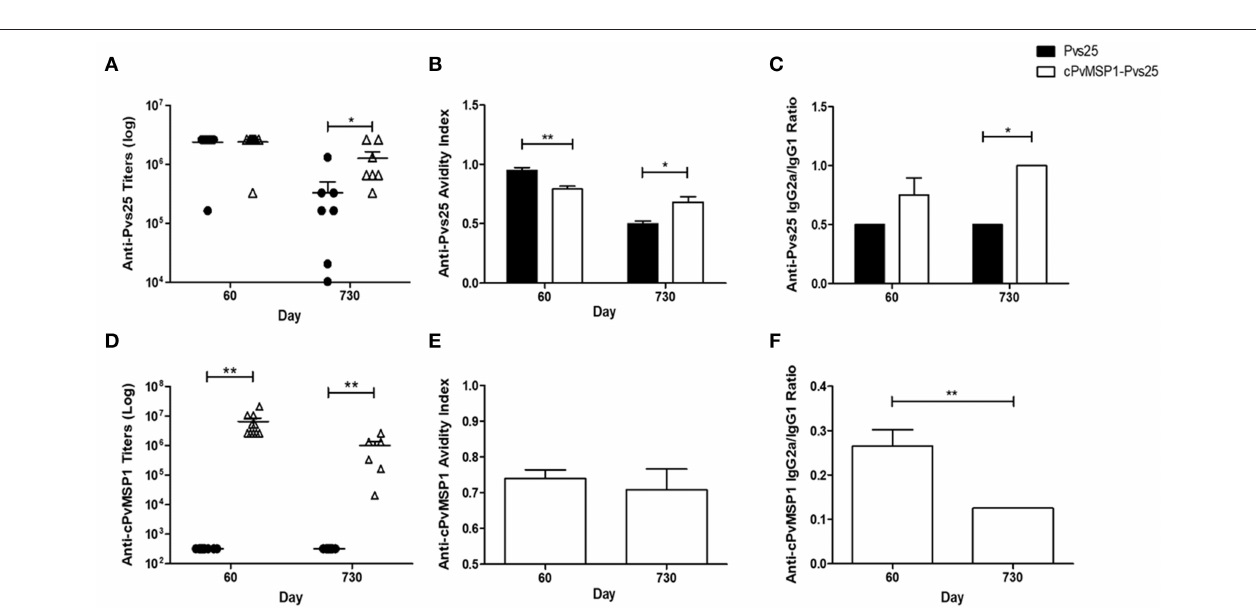
FIGURE 3 | Antibody responses to cPvMSP1 and Pvs25. Antibody responses against the recombinant cPvMSP1 and Pvs25 proteins that form the recombinant cPvMSP1-Pvs25 protein were assessed in CB6F1/J mice following immunization with either Pvs25 (closed circles or bars) or cPvMSP1-Pvs25 (open triangles or bars) on day 60 and 730 after the first immunization. The titers against Pvs25 and cPvMSP1 are shown in (A,D) , respectively. Results are presented for n = 10 mice for day 60 and n = 7 mice for day 730. Avidity indices for anti-Pvs25 and anti-cPvMSP1 are shown in (B,E) . IgG subclass responses, displayed as the IgG2a to IgG1 ratio, are shown in (C) for Pvs25 and (F) for cPvMSP1. Avidity indices and subclass results are presented as the mean values obtained from sera pooled from the 10 mice at day 60 or the 7 surviving mice at day 730, responses were averaged from four technical replicates. Statistical analysis was conducted using unpaired t-tests. Statistically significant differences are denoted by * p < 0.05 and ** p <